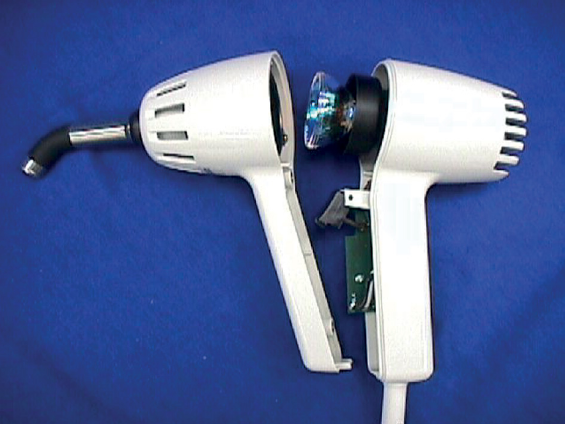
Figure 13. Internal components of a typical QTH curing light.